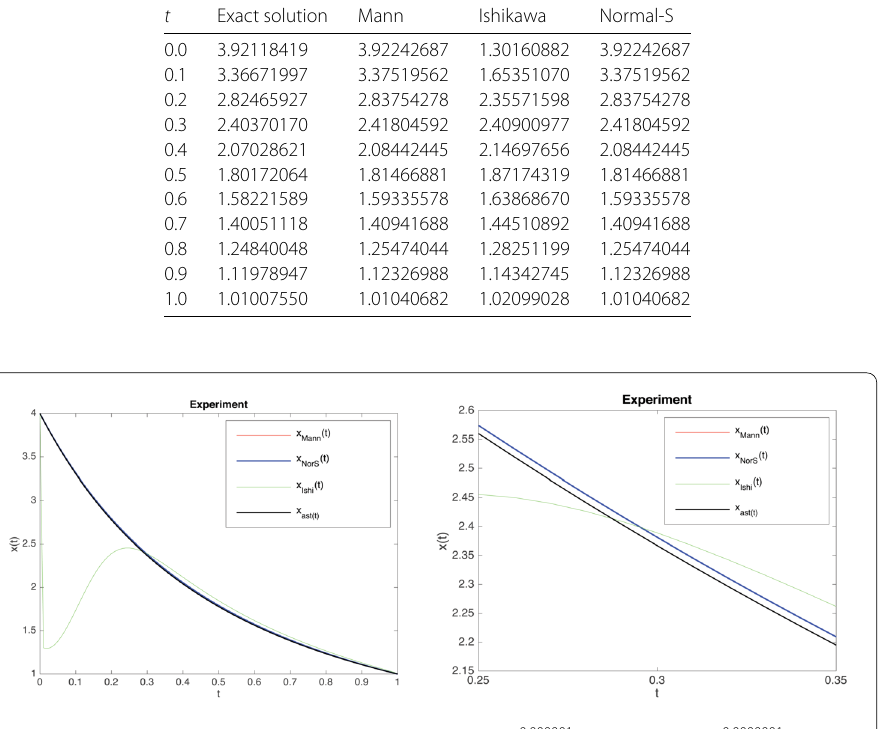
and β n = 0.005 + 0.0000001 n 2 n